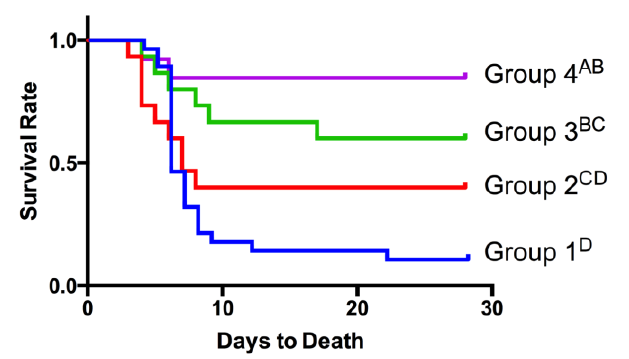
Figure 3. Kaplan Meier survival curves for black-tailed prairie dog groups that consumed placebo or vaccine-laden baits. Group 1 consumed placebo baits containing RCN-TK- and was challenged at 30 or 270 days post initial vaccination (dpv). The other 3 groups consumed baits containing RCN-F1/V307. Groups 2 and 3 were challenged at 30 and 270 dpv, respectively. Group 4 consumed baits a second time 30 days prior to challenge at 270 dpv. Survival curves that do not share a letter are significantly different ( p <